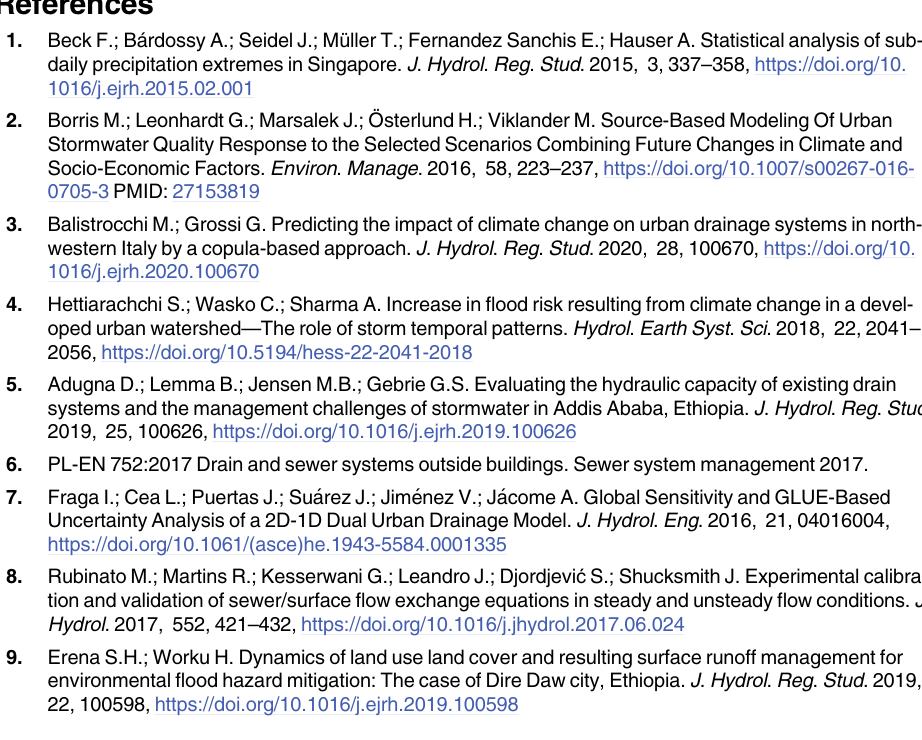
) for selected precipitation stations in Poland. s